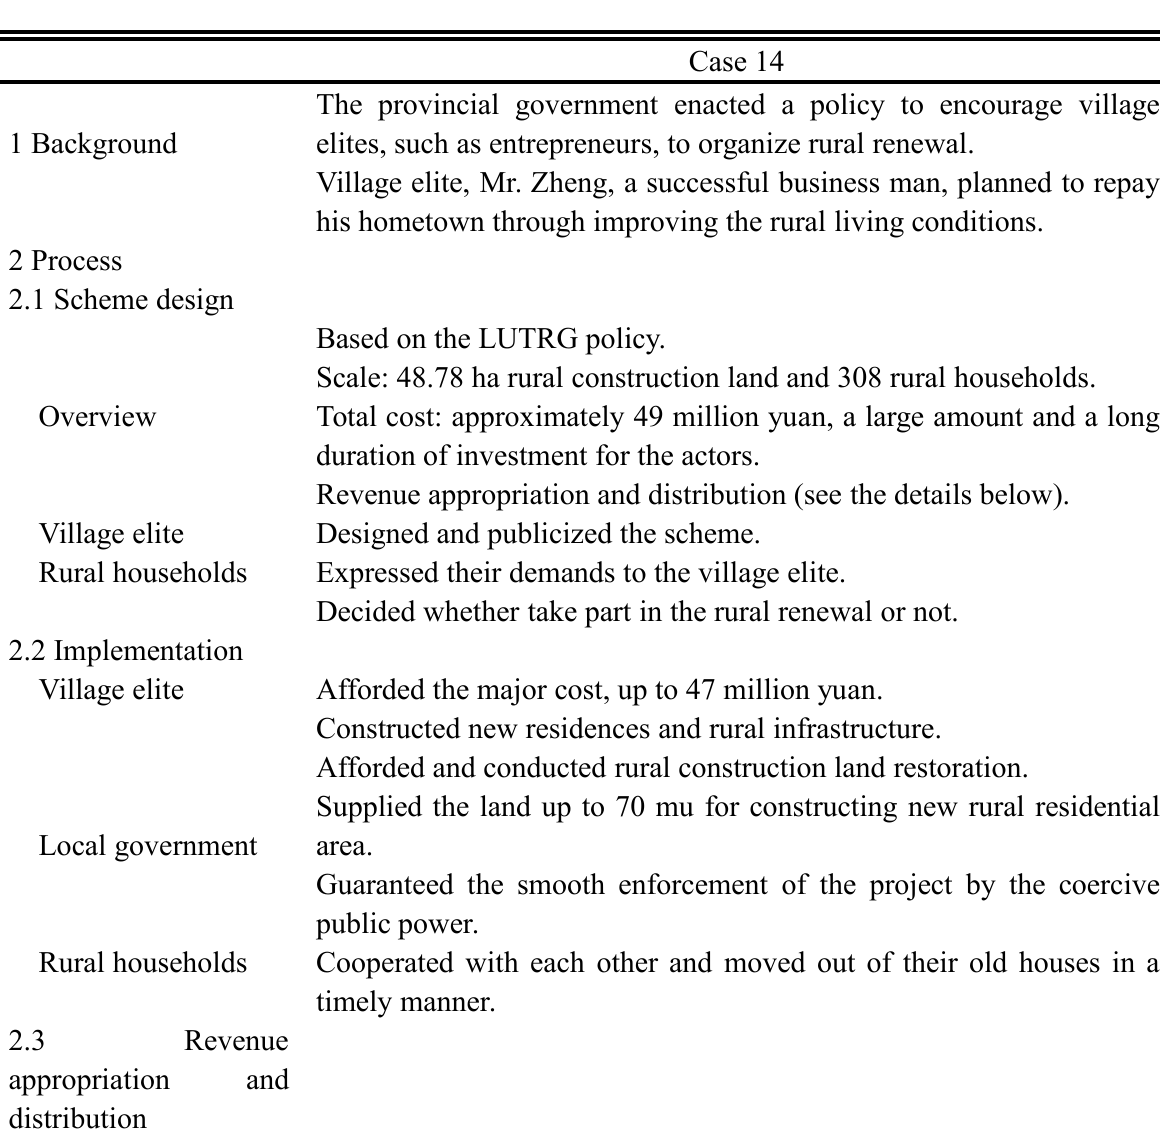
Table A3.3: Archetype 3 Rural renewal with